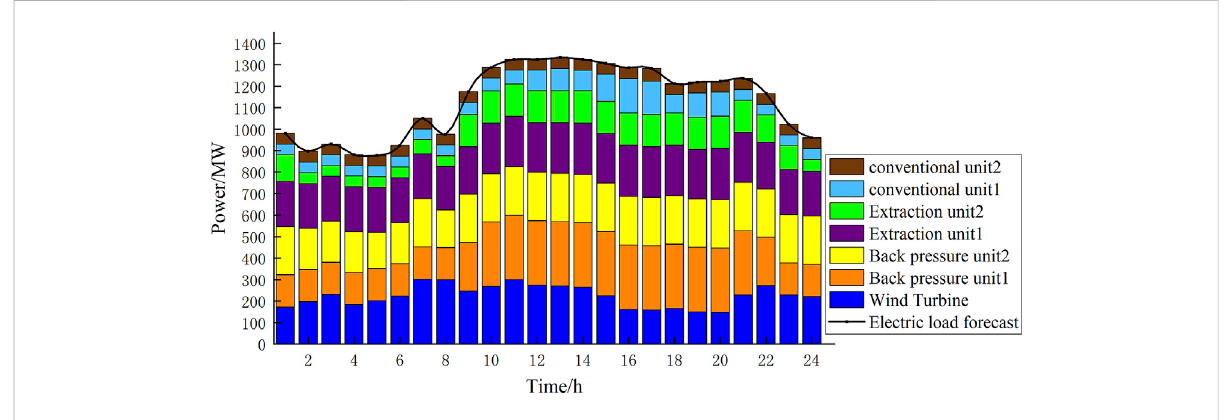
FIGURE 8 Output of each unit.